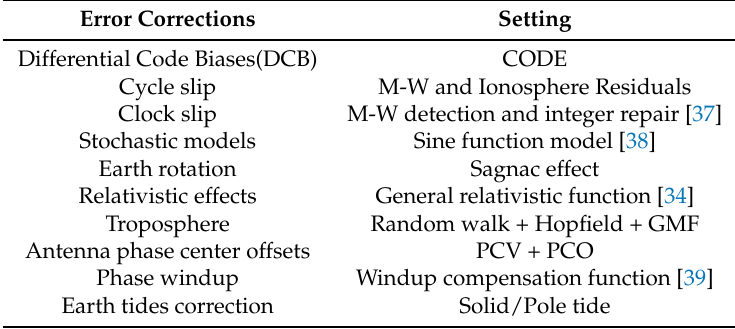
Table 1. Error corrections.